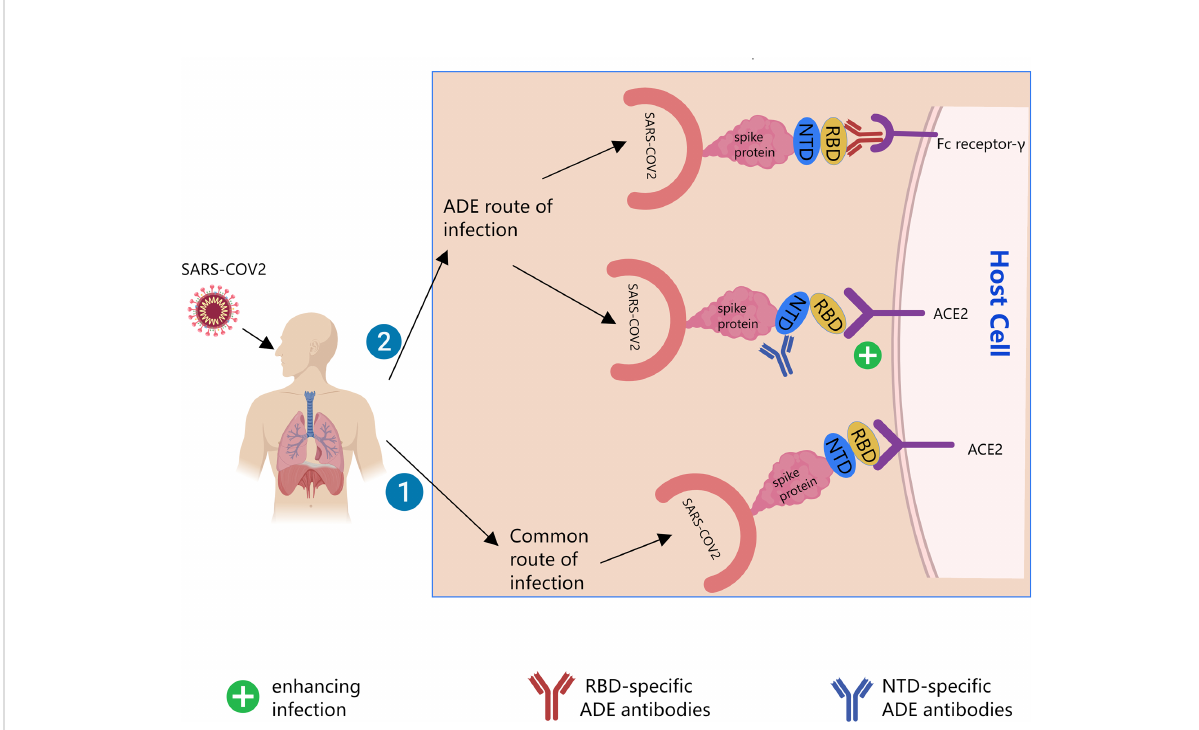
FIGURE 1 Possible mechanisms of Antibody-dependent enhancement (ADE) of SARS-CoV-2. The black line is the path direction of the infection. Pathway 1 is common pathway by which SARS-CoV-2 infect cells. Pathway 2 is possible ADE pathway by which SARS-CoV-2 infect cells. ACE2, angiotensin-converting enzyme 2; RBD, receptor binding domain; NTD, the N-terminal